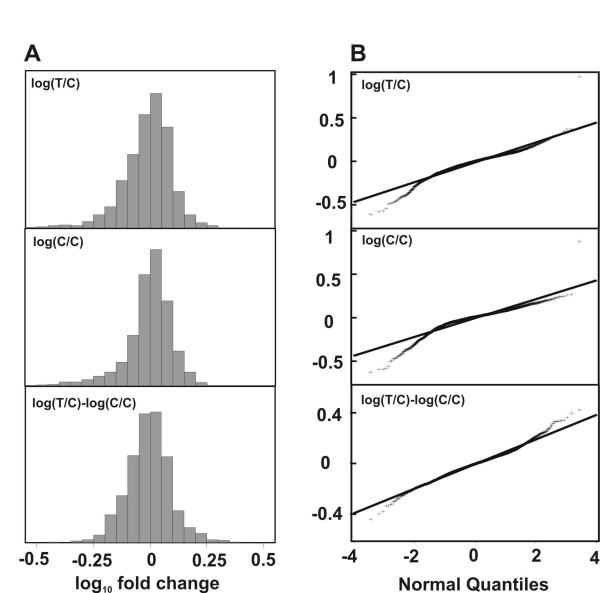
Control correction of each spot markedly improves the distribution of log ratios. (A) Histograms show that T/C and C/C log ratio distributions after lowess normalization still have a marked asymmetry with a larger tail towards the left (increased down-regulated genes). The distribution becomes symmetric after subtracting the log (C/C) from the log (T/C). (B) Quantile-quantile plots similarly show that the log ratio distribution becomes more normal after correction of each spot with the control ratio.